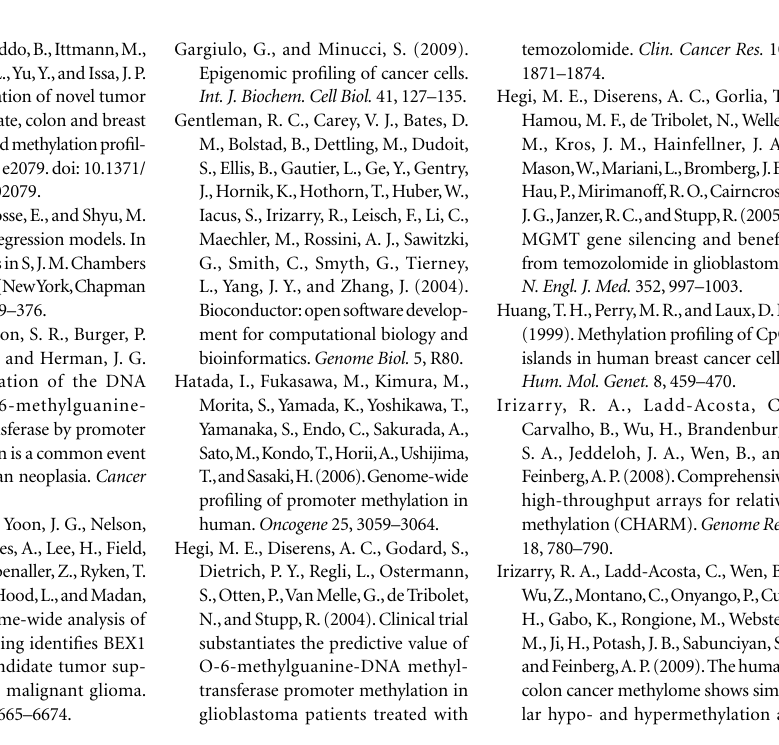
U87MG showing a methylated band (as well as a unmethylated band). For controls, methylated SssI-treated DNA (pos.), and unmethylated whole genome amplifi ed DNA (neg.) were analyzed in parallel. (C) Schematic diagram of bisulfi te sequencing results on all CpG sites in Fragment 2 of uncloned GBM, U87MG, and normal DNA. Open circles indicate unmethylated CGs, and closed circles indicated methylated CGs. CGs in context of CCGG are enclosed in rectangles. Half-fi lled circles indicated sites where C peak (methylated) and T peak (unmethylated) from bisulfi te sequencing were detected